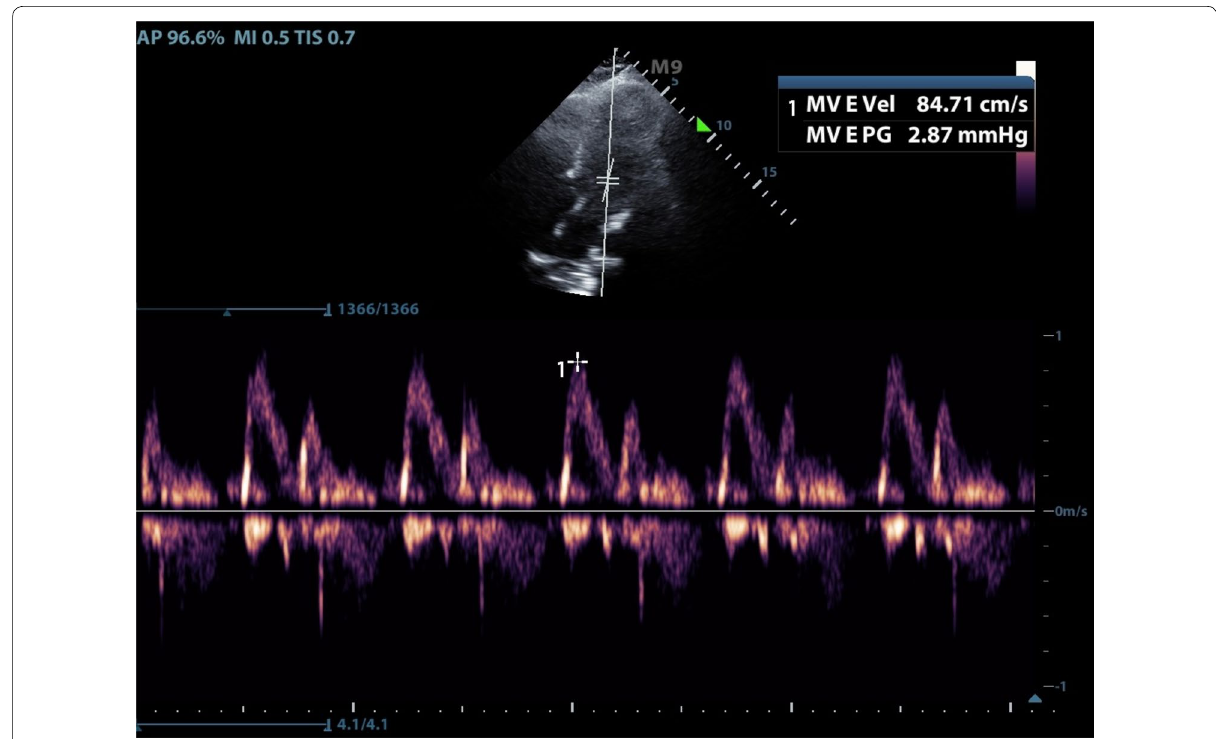
Fig. 3 Measurement of mitral valve E in apical